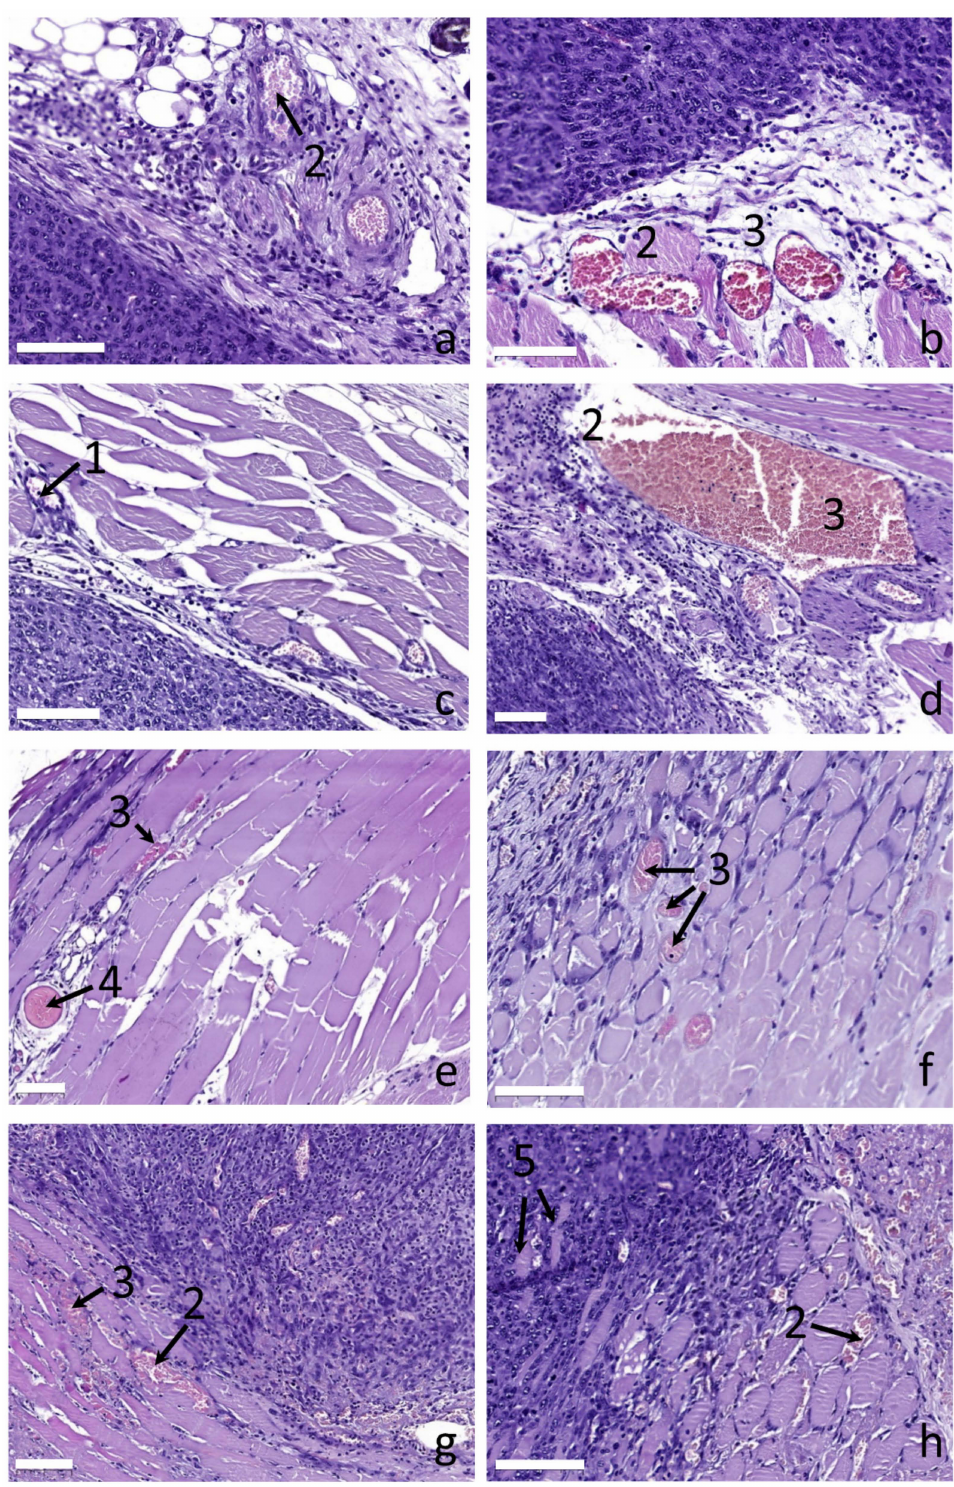
Figure 6. Histological images of blood vessels in peripheral tissues supplying tumor for different groups: ( a , b ) untreated, ( c ) irradiation only at 660 nm, ( d ) irradiation only at 405 nm, ( e , f ) PDT at 660 nm, ( g , h ) PDT at 405 nm. Numbers show: (1) normal vessels, (2) destruction of vessels endothe- lium, (3) stasis/sludges, (4) thrombosis, (5) myocytes within tumor tissue. The bar size is 100 µ